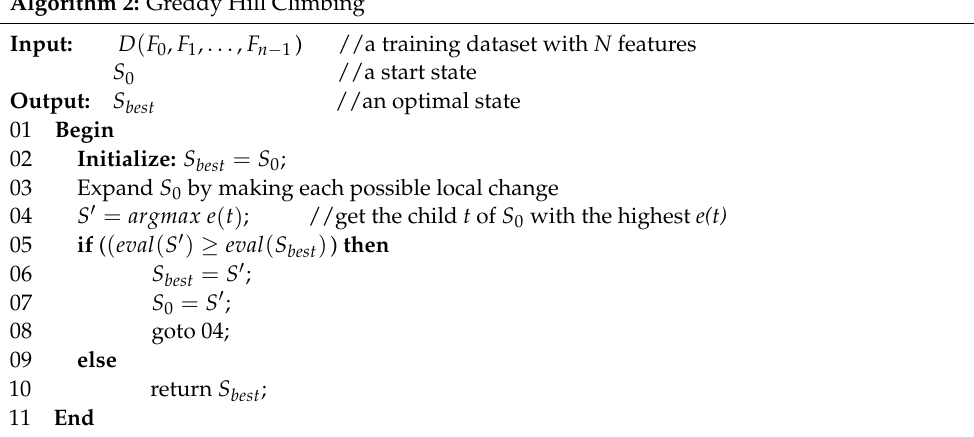
Algorithm 2: Greddy Hill